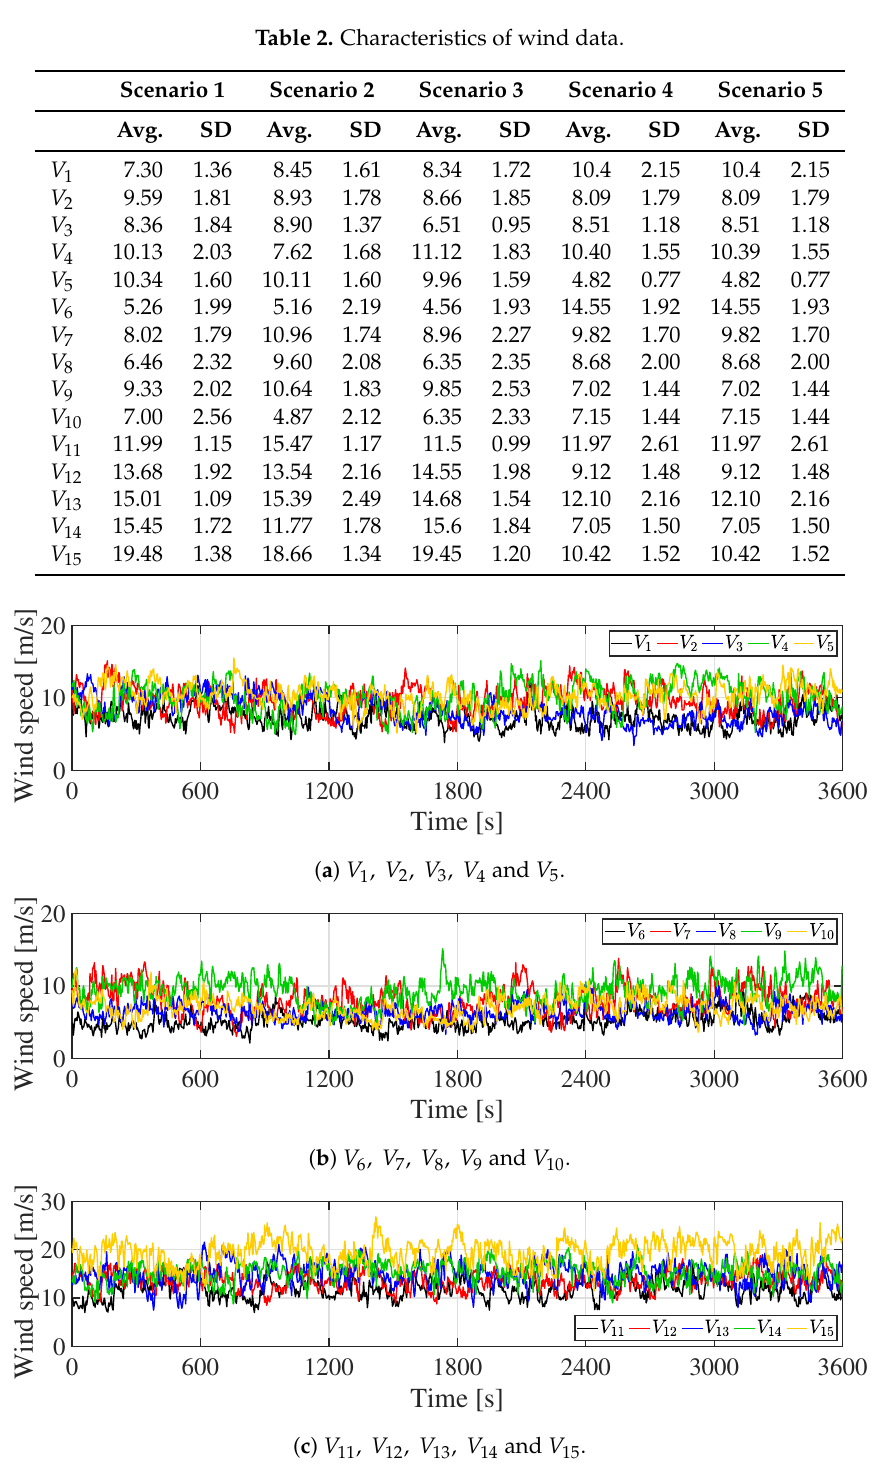
Figure 8. Wind speed (Scenario